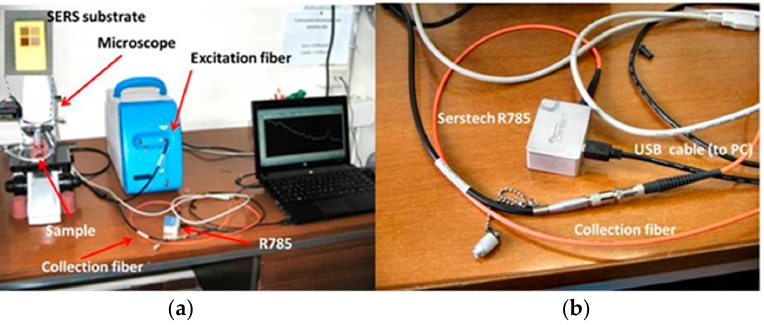
Figure 1. ( a ) A picture of the experimental set-up comprising the laser source, the microscope, the R785 minispectrometer. In the upper left a magnification of the SERS substrate used showing the four different quadrants; ( b ) A magnification of the R785 with the collection fiber through which the SERS signal is sent to the device and the USB data and power cable. signal is sent to the device and the USB data and power cable.